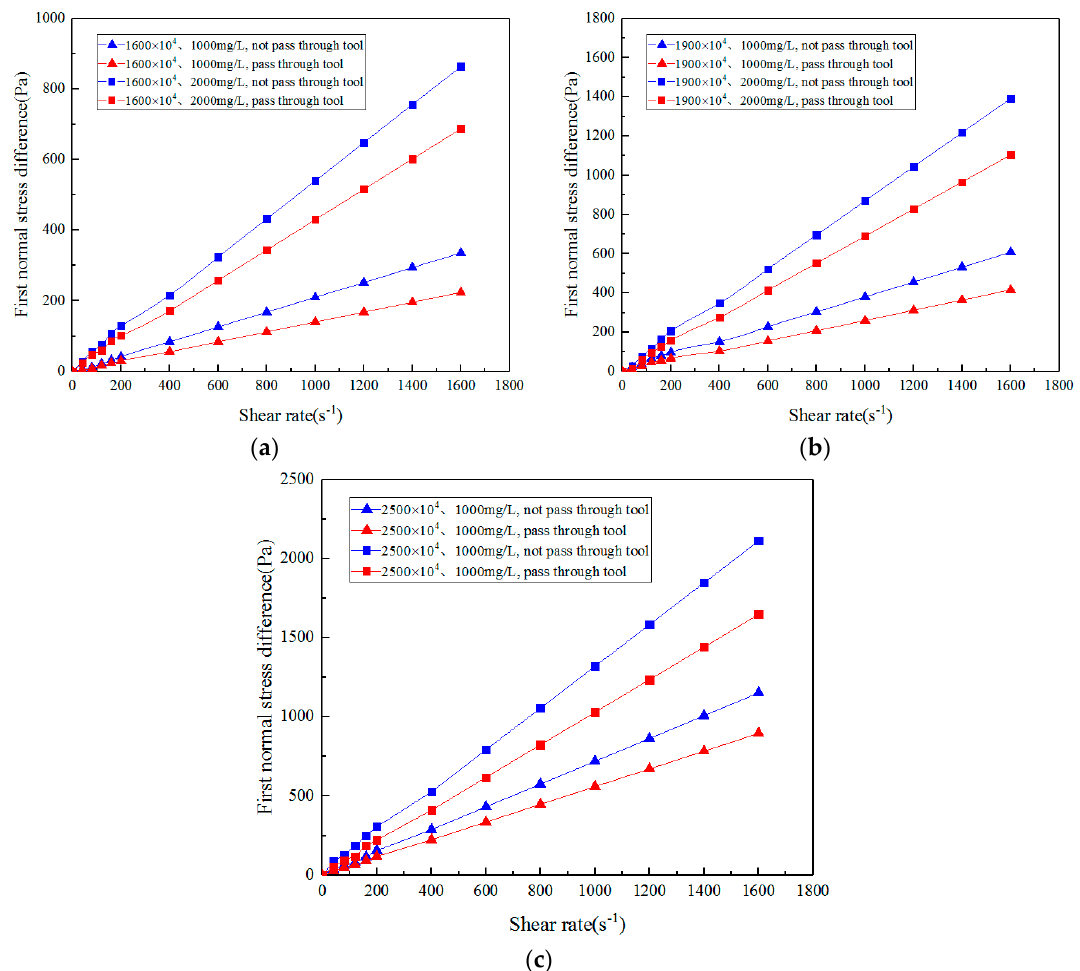
Figure 7. Variation of first normal stress difference with shear rate before and after ASP solution flows through the different medium tool: ( a ) 16 million (MD); ( b ) 19 million (MD); ( c ) 25 million (MD).